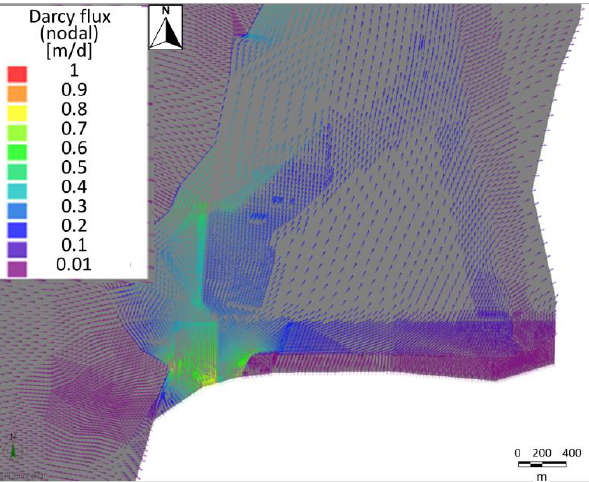
Figure 11. Groundwater velocity vectors (ranked by colors), demonstrating the massive leak through the Ye’elim fan delta (see Figure